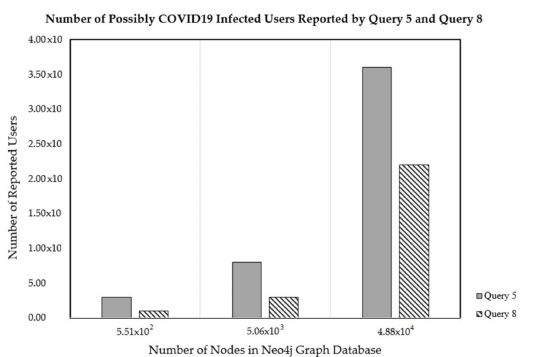
Figure 15. Number of possible COVID-19 infected users reported by different contract tracing applications in the Neo4j database with different number of nodes. Table 7. Comparison of average execution time for Query 5 (contact tracing) and Query 8 (enhanced contact